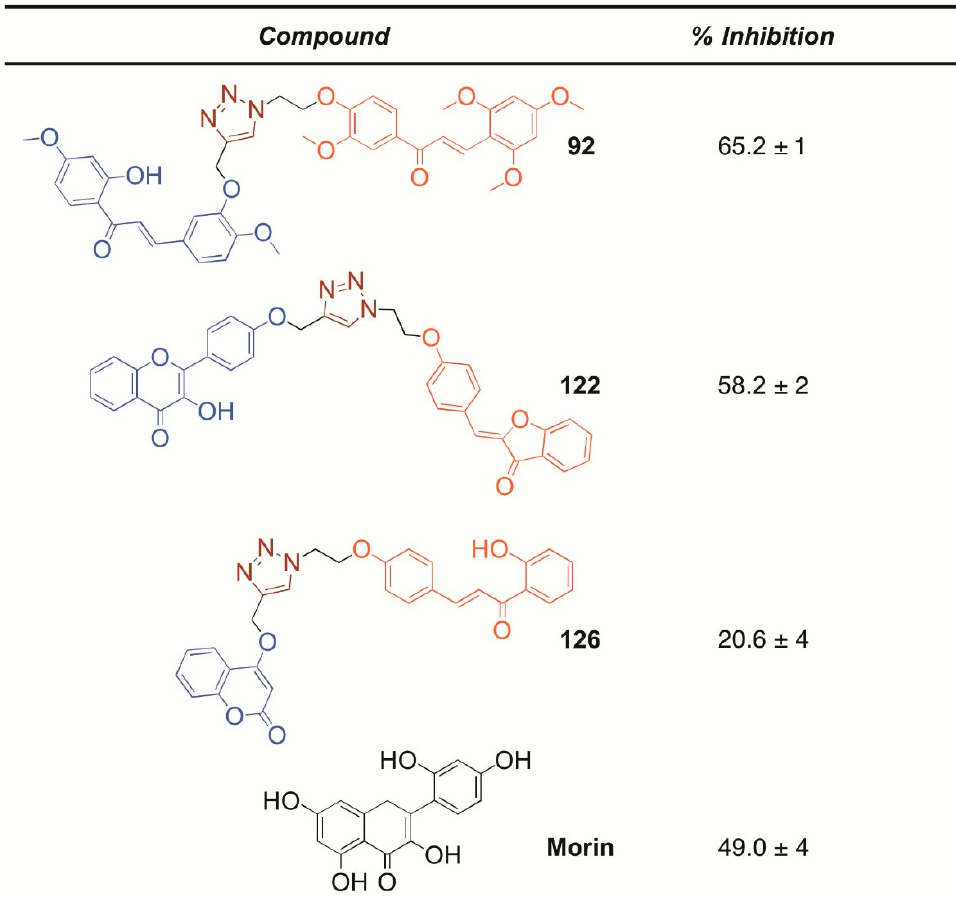
Figure 2. Percentage inhibition of A β 42 aggregation achieved by compounds 92 , 122 and 126 (50 μ M concentration) relative to that of A β 42 alone (10 μ M), where 100% represents complete aggregation inhibition and 0% shows no inhibition. The data represents the averages and standard error from the results of three independent biological repeats. Inhibitory effect of morin determined under identical assay conditions.